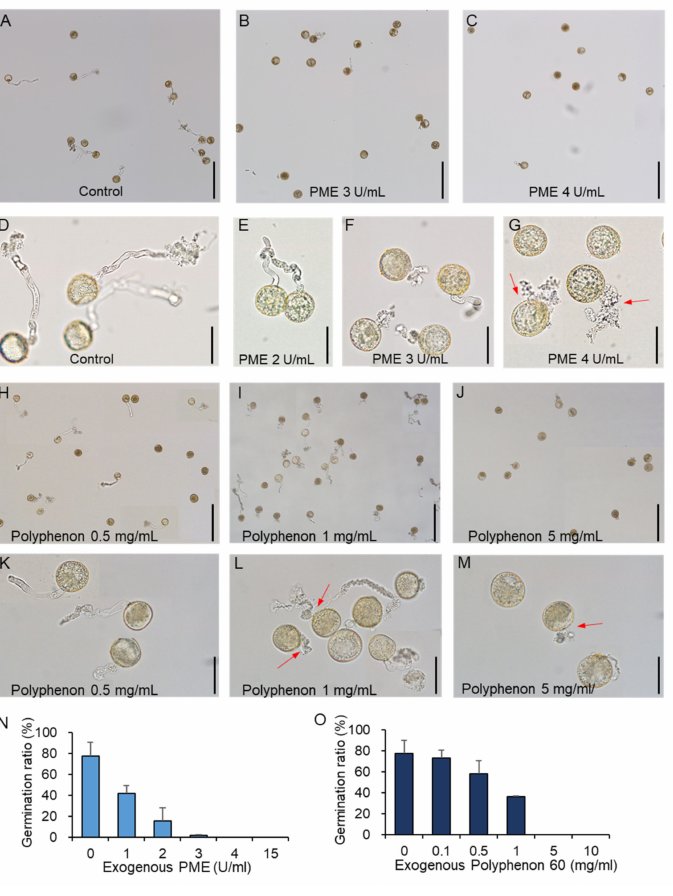
Figure 1. The e ff ect of PME and Polyphenon 60 treatments on rice pollen germination and tube growth. In vitro pollen germination of rice pollen were analyzed on the liquid germination media without ( A , D ) and with exogenous PME ( B , C , E – G ) and Polyphenon 60 ( H – M ). The concentration was indicated in each image. Red arrows indicate pollen grains which rupture early without forming intact pollen tubes. Bars = 200 µ m ( A – C , H – J ) and 50 µ m ( D – G , K – M ). ( N , O ) The percentage of germinated pollen grain with an intact tube was presented. Red arrow marks pollen grains with burst or disintegrated tubes. Three independent experiments + SD ( n >